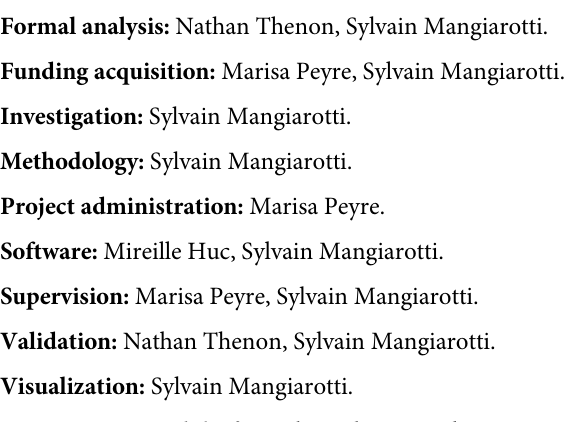
S1 Table. Dynamical regimes of the models. The models dynamics was investigated consid- ering 100 000 integration time steps of 0.1 day each (corresponding to a duration of 24 years). Metastable is mentioned when the integration could be checked on 20 000 time steps ( * 6 years) only. P1, P2 and P5 refer to period cycles of period one, two and five, respectively. Toroidal chaos refers to chaotic attractors structured around, and bounded by, a toroidal structure (see [48] for details). S2 Table. Models forecasting performances. Models forecasting performances: forecasting error (in % of the maximum value observed during the modelling period), for a 10 day predic- tion horizon (90% confidence level) of daily cases and deaths per million inhabitants. Error level is provided for the validation window and also (in brackets) for the modelling window. The modelling and validation (in brackets) period length (in day) are also